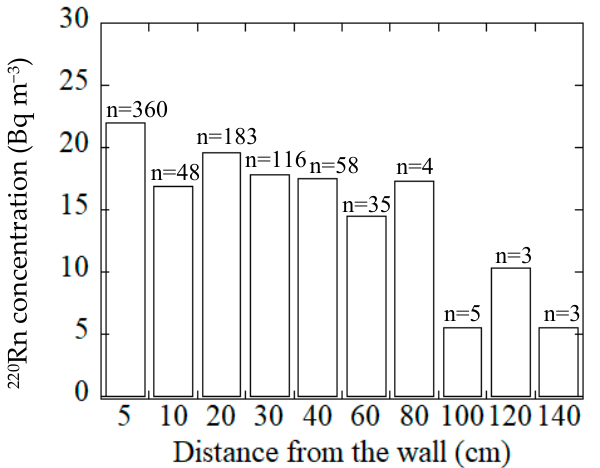
Figure 4. 220 Rn concentrations at different distances from the wall surface for all wall materials.